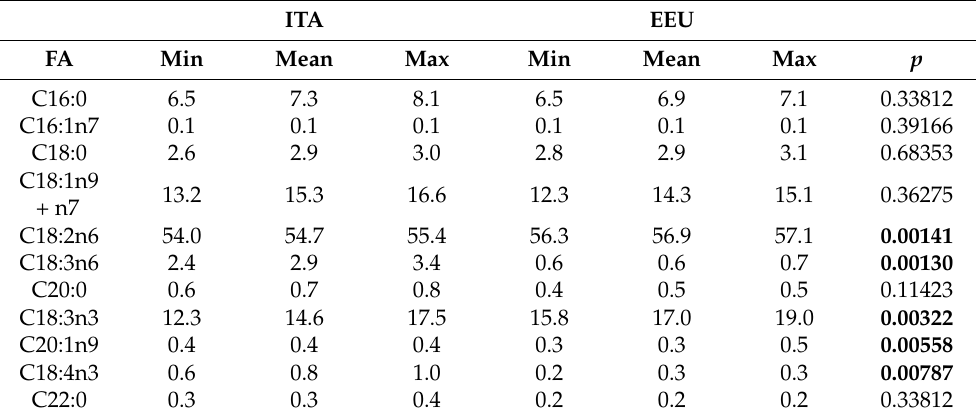
Table 1. Total % fatty acid composition (minimum, mean, maximum values, % mol, n = 4) of HSO